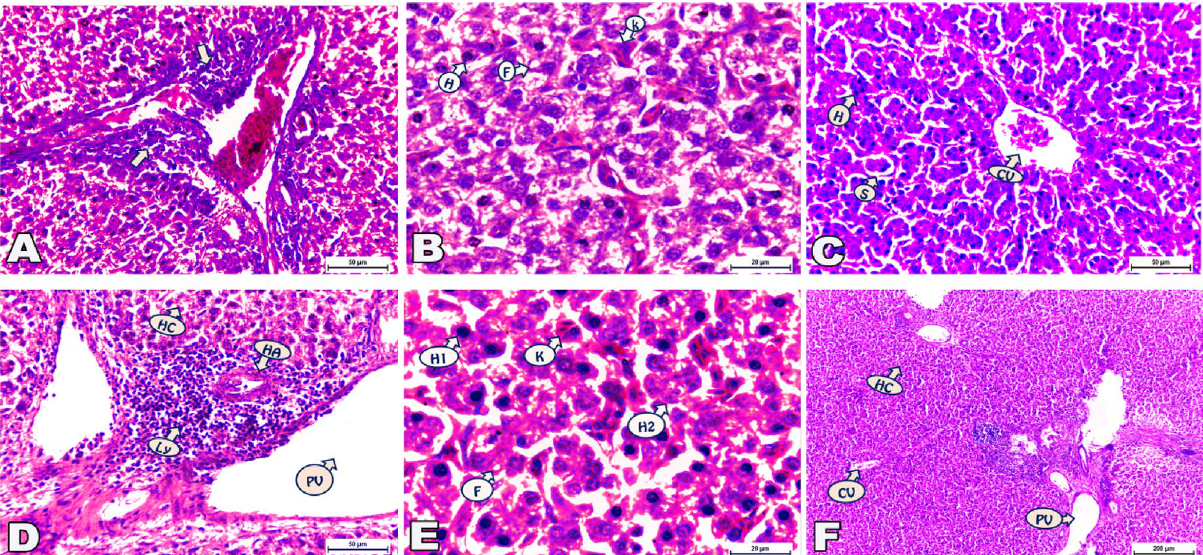
Figure 2. ( A – D ) Photomicrographs displaying the effect of ZnONPs supplement on the normal hepatic architecture of the tested broilers. In 40 mg ZnONPs group, ( A ) Inflammatory cells infiltration (arrows) presented in portal area. ( B ) Hepatocytes (H) were dispersed between fat droplets (F), von Kupffer cells (k), and dilated sinusoids. In 60 mg ZnONPs group, ( C ) Area of central vein (CV) supported by hepatocytes (H) and sinusoids (S). ( D ) Portal area displayed portal vein (PV), hepatic artery (HA), inflammatory cells infiltration (Ly), and Hepatic cords (HC). ( E ) Parenchyma of liver tissue marked hepatocyte in normal (H1)